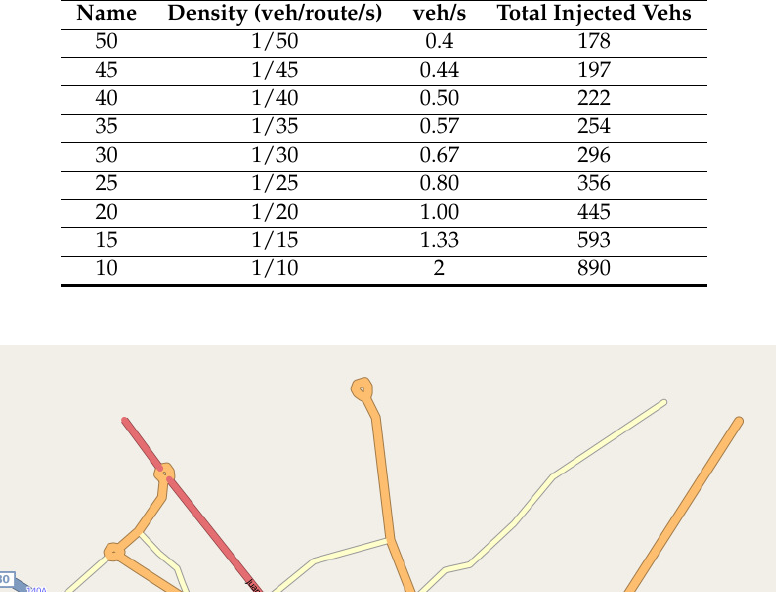
Table 6. Detailed information about the different traffic densities generated for the simulations.